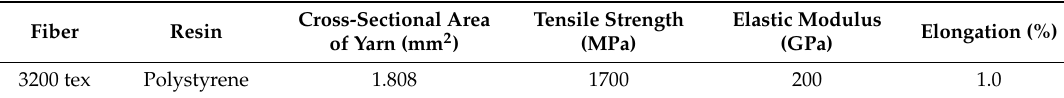
Table1. Materialpropertiesofcarbongrid-typetextileinwarpdirection(suggestedvaluesbythemanufacturer). Fiber